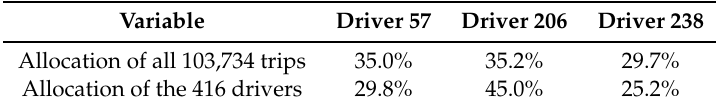
Table 6. Allocation of all trips to the three drivers 57, 206 and 238, and allocation of the drivers to the three selected drivers according to the likelihood of the individual trip